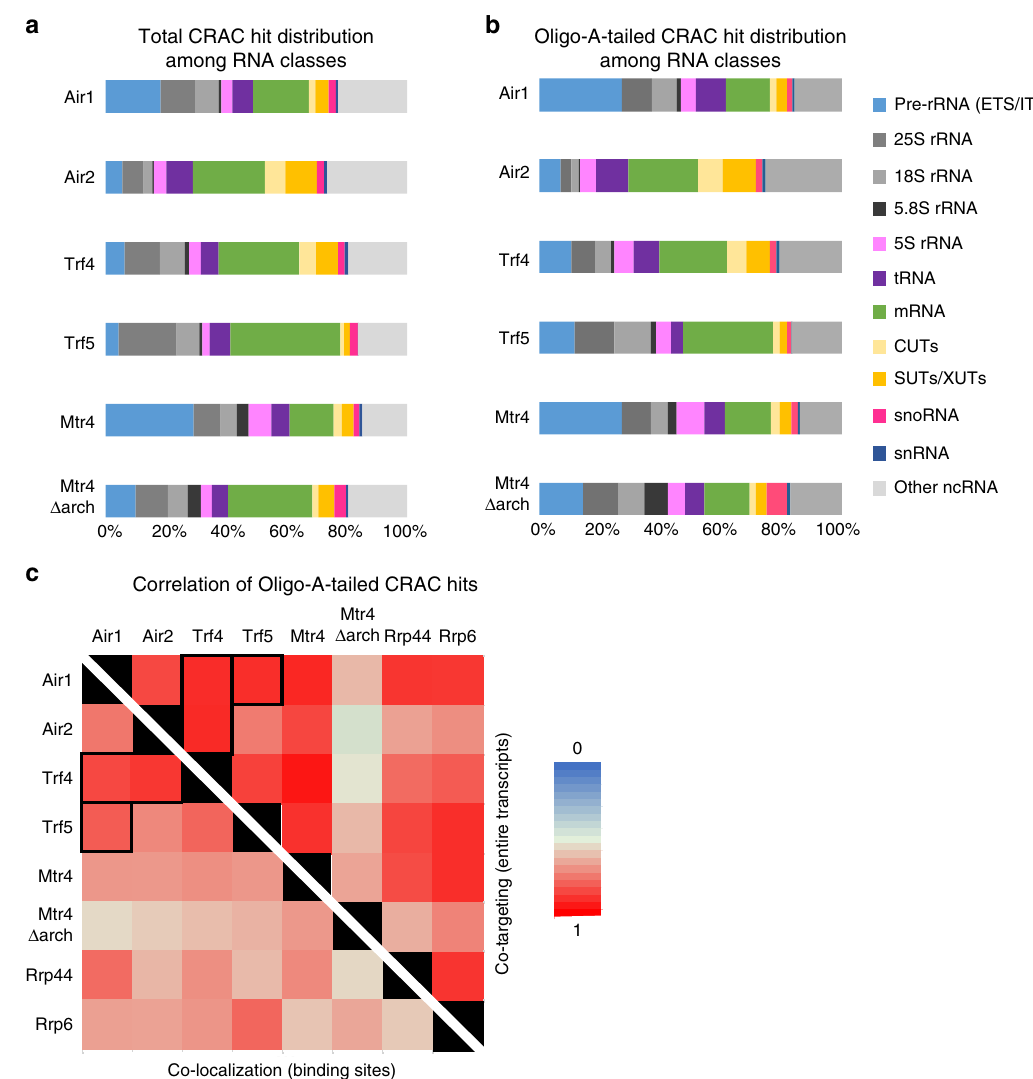
Fig. 2 RNA interactions by TRAMP components. a , b Distribution of all ( a ) and non-encoded A-tailed ( b ) reads mapped to different RNA substrate classes recovered in CRAC datasets. Two biological replicates were averaged for each protein. c Correlation matrix displayed as a heat map showing correlation between binding sites recovered with different factors. Note: Above the diagonal, the matrix shows the extent to which the factors target the same RNA species as “ co-targeting of RNAs. ” Below the diagonal, the matrix shows the extent to which the factors target the closely positioned RNA sites ( ≥ 50 nt) as “ co-localization of sites. ” See Supplementary Data 4 for values for individual CRAC